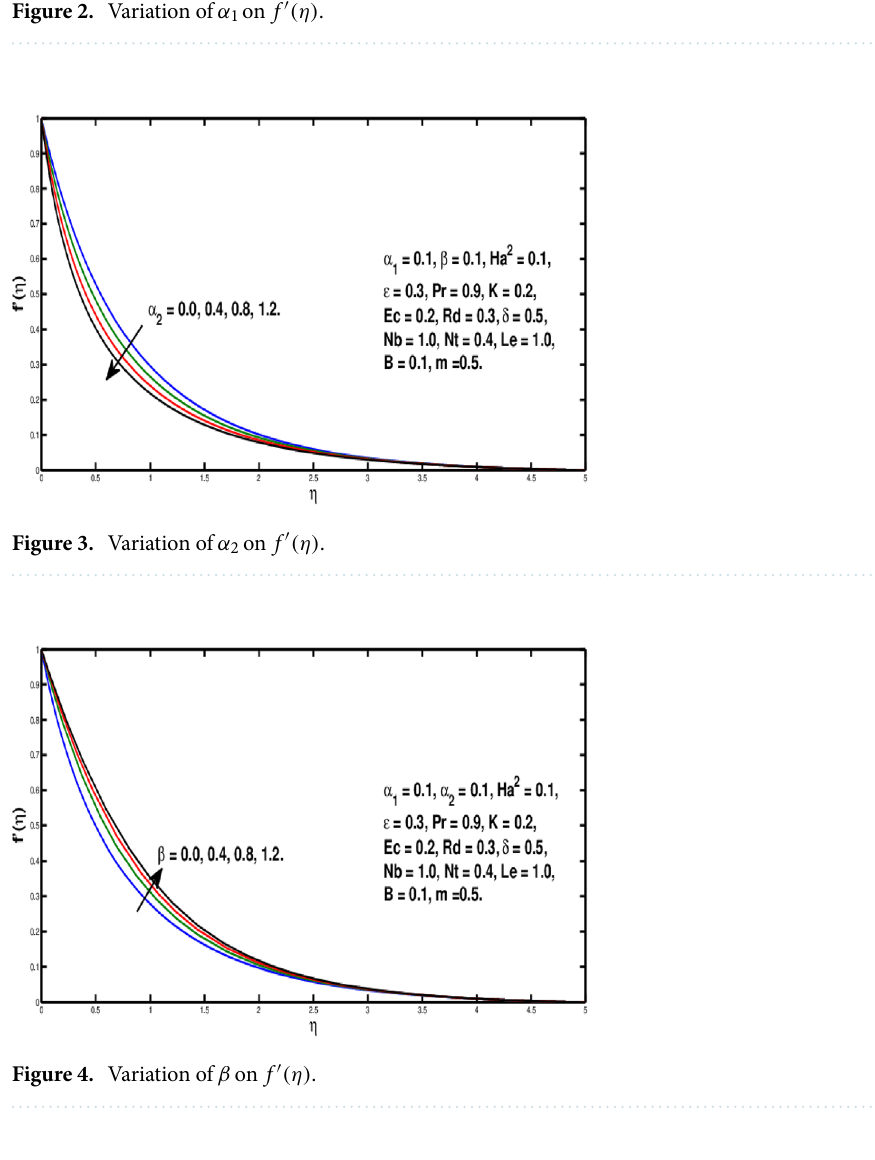
Figure 2. Variation of α 1 on f ′ (η) .